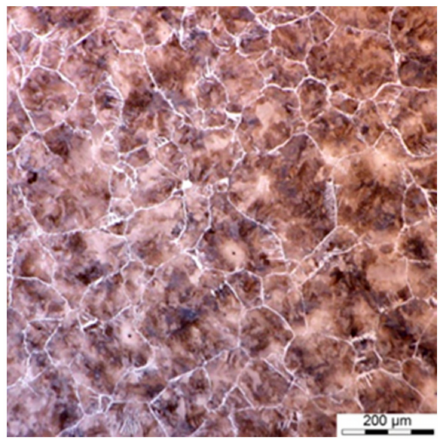
Figure 8. Microstructures of steel C before the first